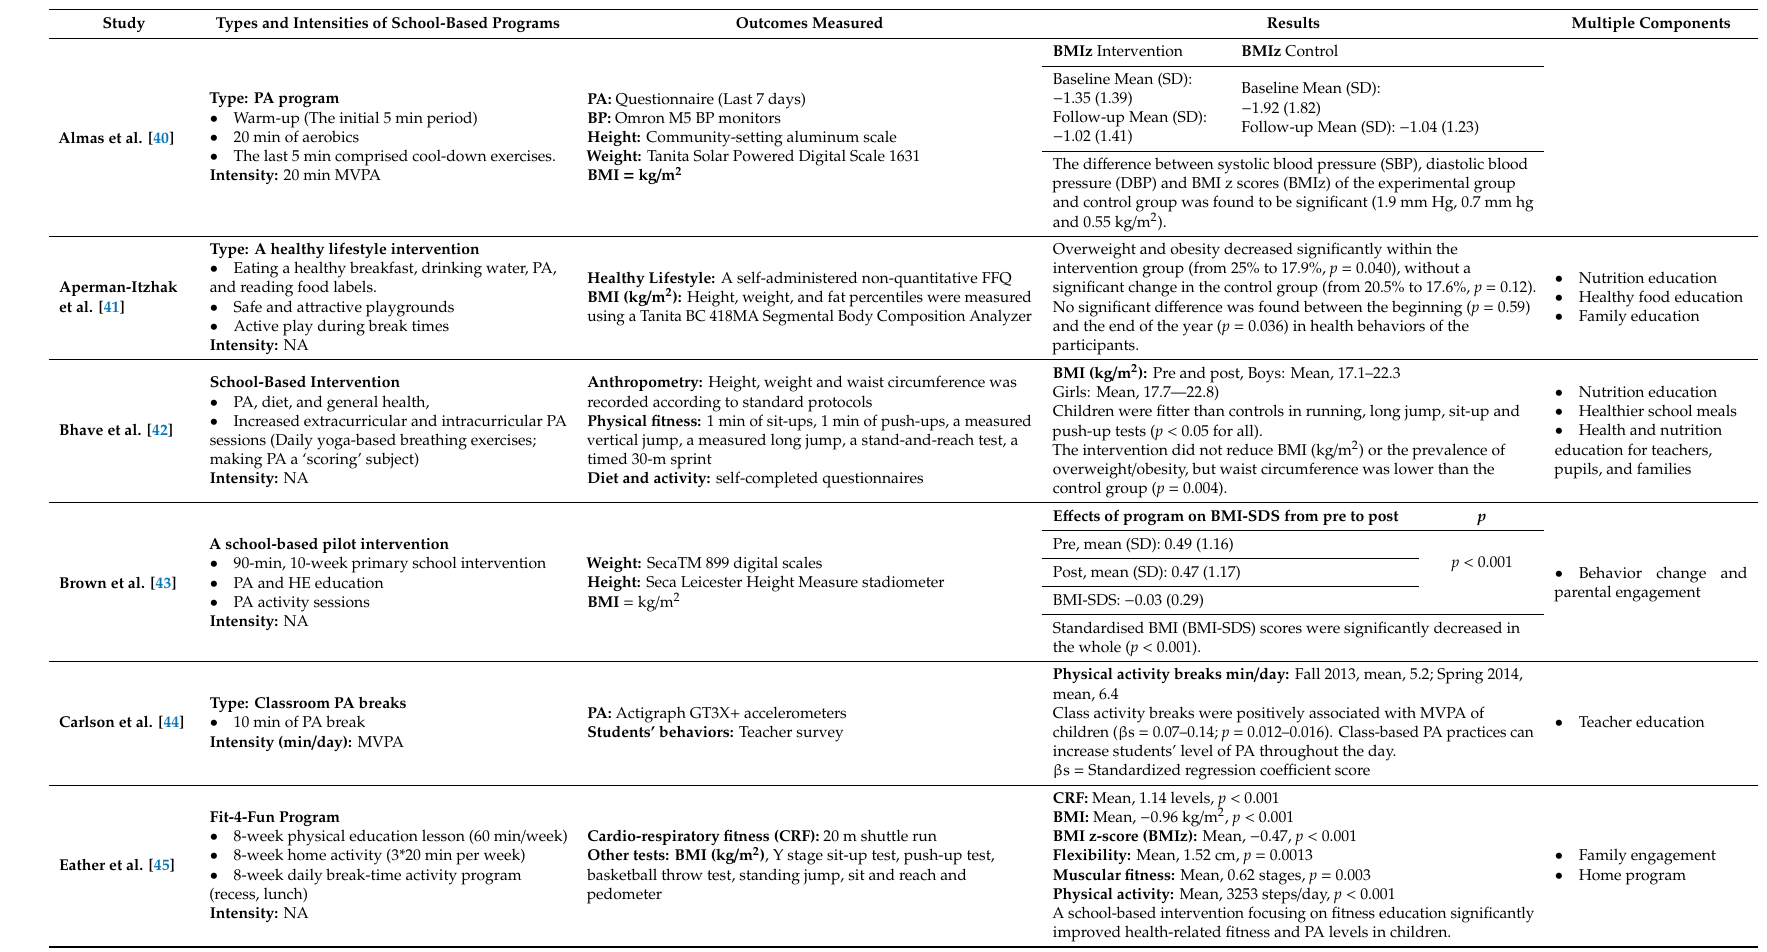
Table 4. Details of the